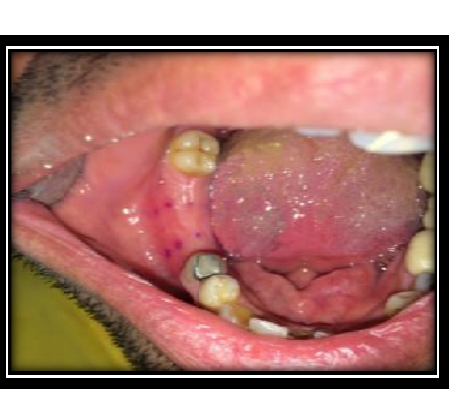
Fig.1: Localization of points in the patient mouth. An impression is taken to the jaw of the patient dimensional changes. The done points were